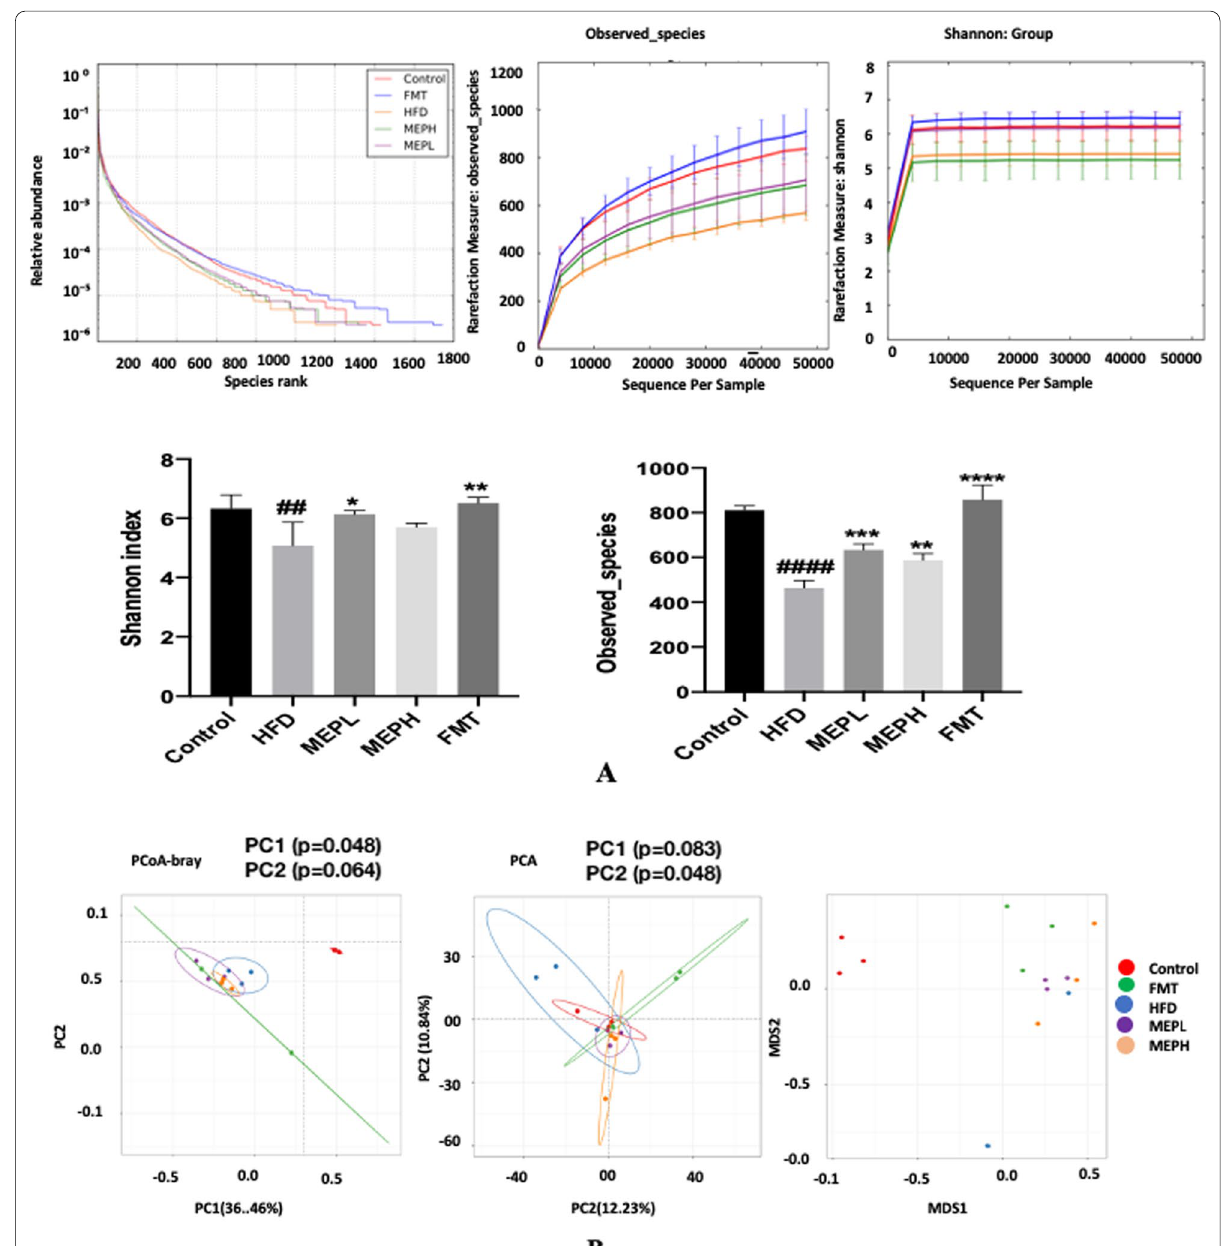
Fig. 8 Effect of MEP on alpha and beta diversity indices in HFD-induced obese mice. A Alpha diversity was shown in the Rank abundance curve, observed species, and Shannon. The rank abundance curve indicates microbial richness and abundance, respectively. B The PCoA, PCA, and NMDS plots were used to assess beta diversity. Every point represents each sample independently. Points with various colours suggest different treatment groups. The distance between the various points represents the similarities and variations of the microbial population